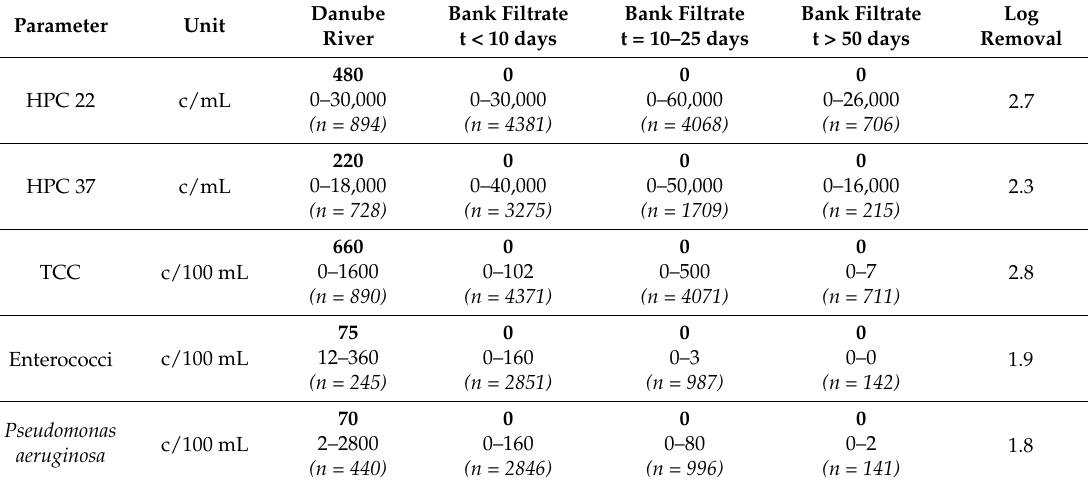
Table 5. Microbiological parameters, median (min–max), Danube River water and bank filtrate with different travel time (t), 2006–2017.